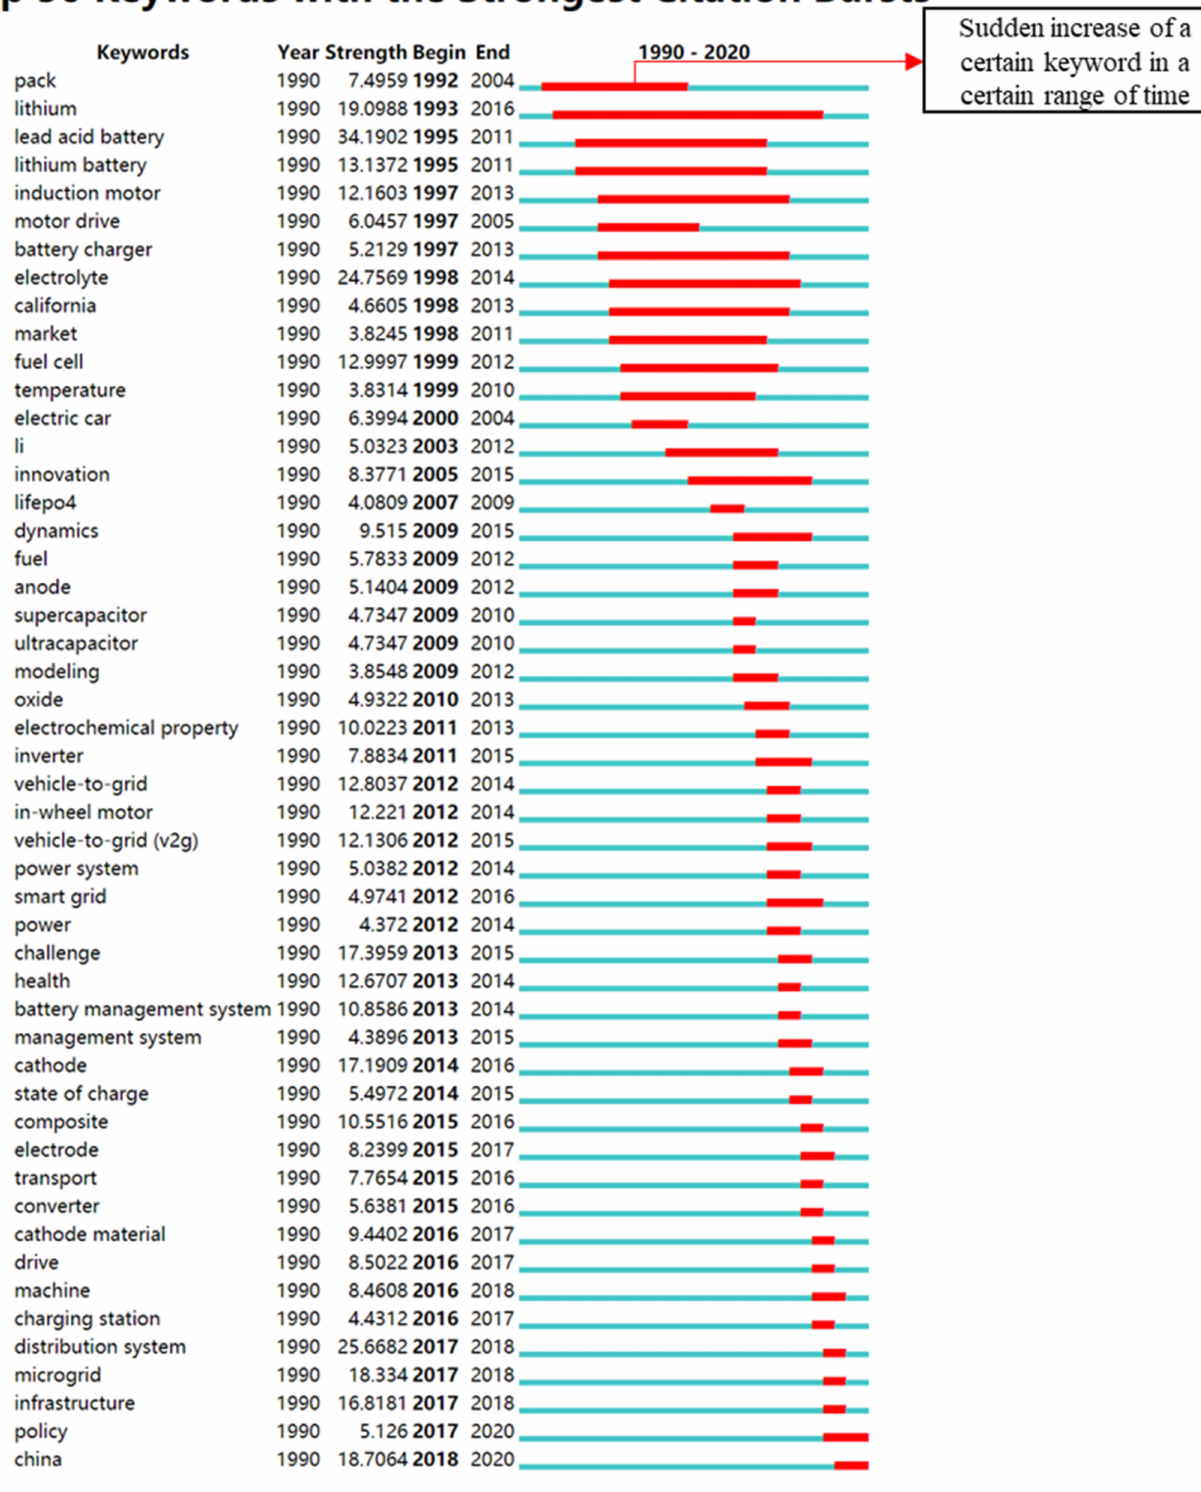
Figure 9. Keywords burst for EV